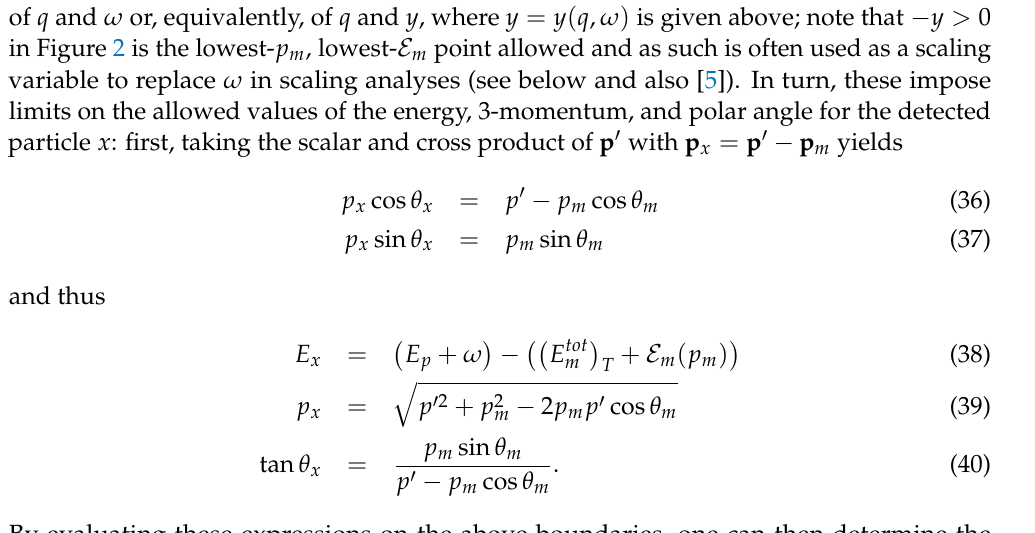
( − p m ) has cos θ m = π . (The variables employed here m